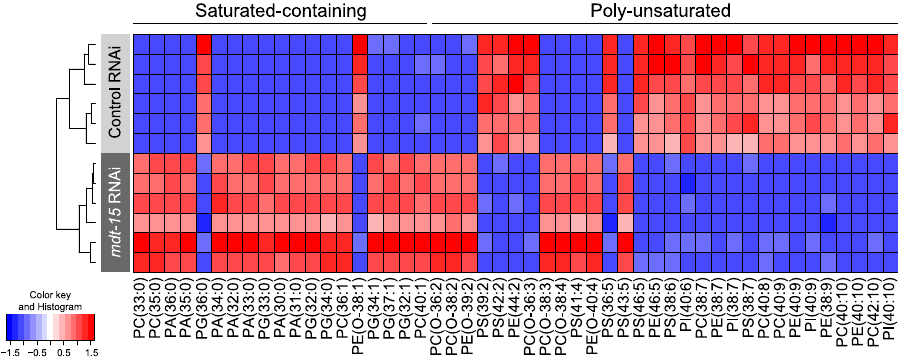
Figure 3. Phospholipid (PL) profiles in C. elegans after mdt-15 RNAi. Unsupervised hierarchical clustering of PL composition in N2 worms treated with mdt-15 RNAi. After mdt-15 RNAi, worms accumulated PLs with saturated acyl chains, and had decreased levels of PL species with a high degree of unsaturation ( ≥ 6 double bonds). Abundance of PLs with “intermediate” degree of saturation (1–5 double bonds) did not present a standard pattern between the mdt-15 -treated and control worms. Phospholipids are designated as C(XX:Y), where XX denotes the total number of carbon atoms and Y the total number of double bonds in the fatty acyl chains. See also Supplementary Table